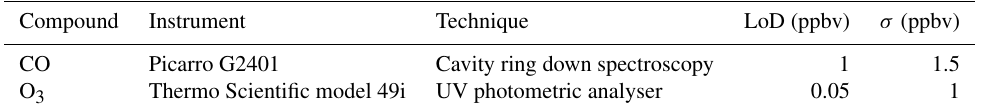
Table 1. In situ routine observations at RUN and their respective limits of detection (LoDs) and statistical uncertainties ( σ ) (Zhou et al., 2018; Duflot et al., 2019).